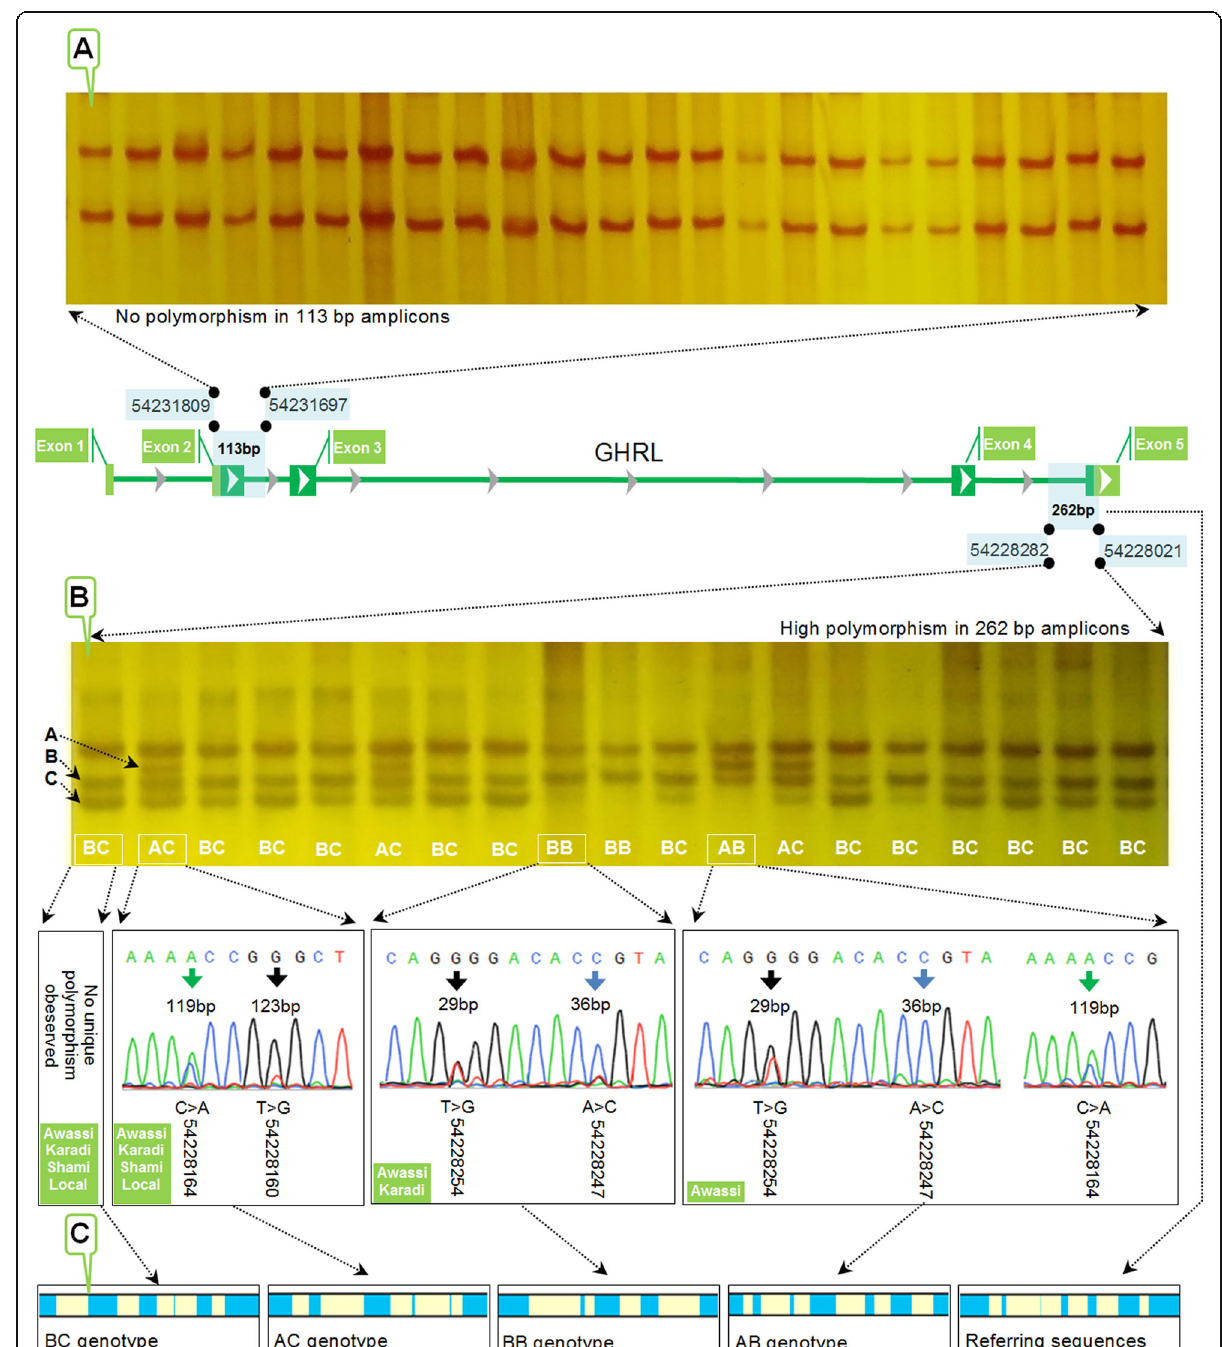
Fig. 1 PCR-SSCP sequencing patterns of GHRL gene in Awassi, Karadi, Shami, and Iraqi Native breeds. a The monomorphic nature of the 113 bp spanning over exon2/intron 2. b The polymorphic nature of 262 bp spanning over intron 4/exon 5. c The in silico consequences of several RNA motifs predicted in the referring sequences as well as each observed diplotype of the 262-bp